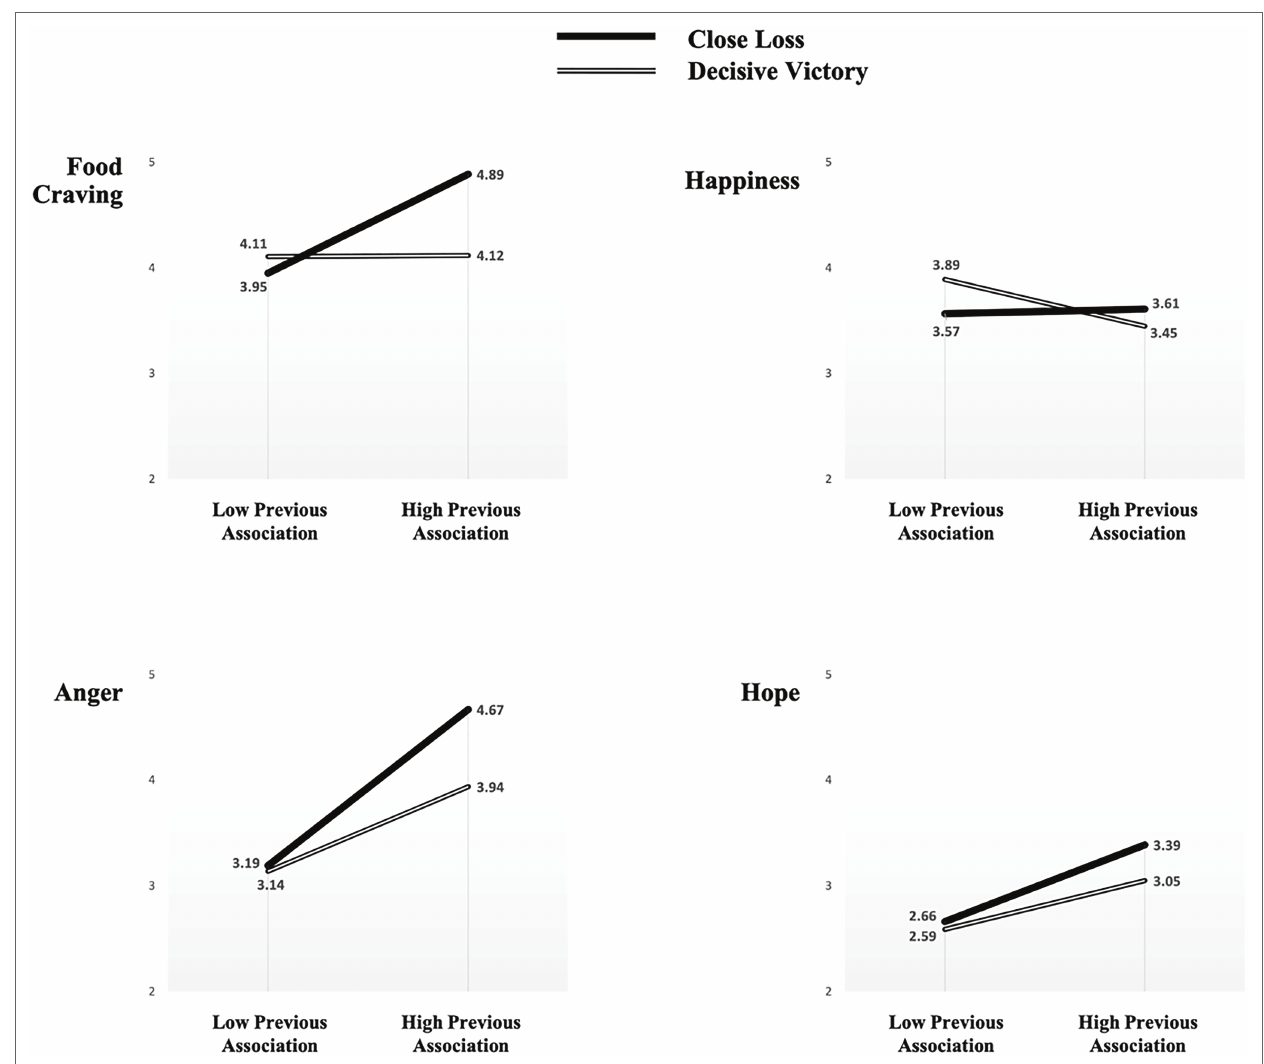
FIGURE 2 | A summary of the 2 (previous association between and eating: low vs. high) × (game situation: close loss vs. decisive victory) results in Experiment